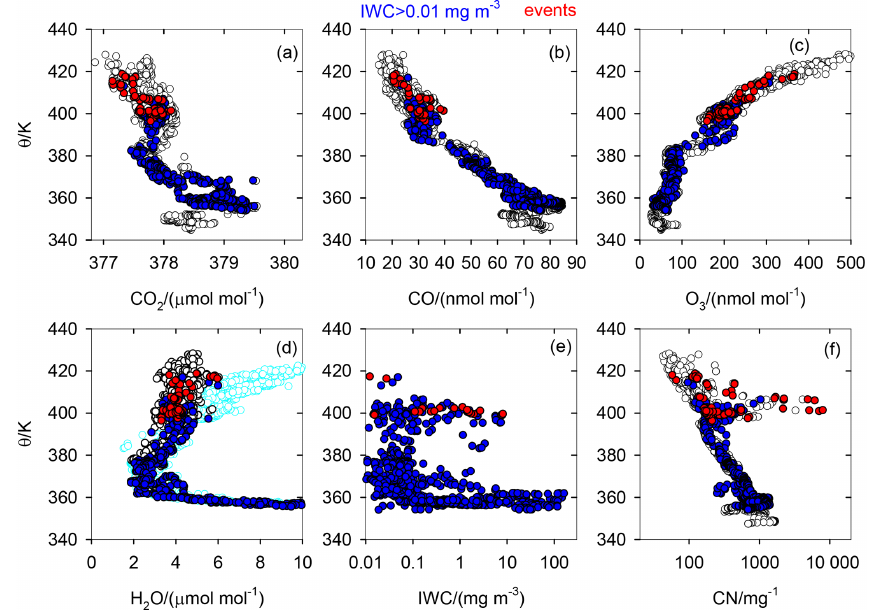
Figure 8. Scatter plots of tracers versus potential temperature θ : molar mixing ratios of (a) CO 2 , (b) CO, (c) O 3 , (d) H 2 O (from FLASH) and ice-saturation mixing ratio (from TDC), (e) ice water content (maximum from FISH-FLASH and FSSP + CIP), and (f) mass-specific nv particle concentration. White: all data; blue: IWC >0.01mgm − 3 ; red: within 10s to a potential plume encounter. Cyan in (d) denotes the H 2 O molar mixing ratio for ice saturation. Data interpolated to the same time with 0.2Hz resolution, for 30 November 2005.